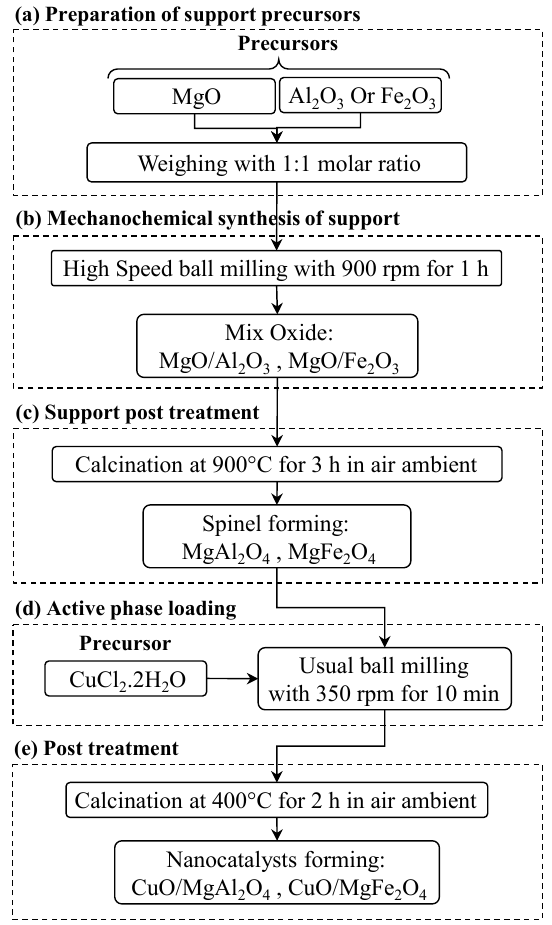
Figure 10. Mechanochemical synthesis of CuO / MgAl 2 O 4 and CuO / MgFe 2 O 4